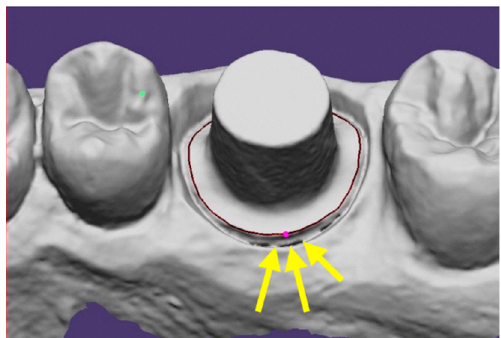
Figure 4. The finish line was automatically set by exocad software when clearly detectable, while in other cases manual adjustments were needed.